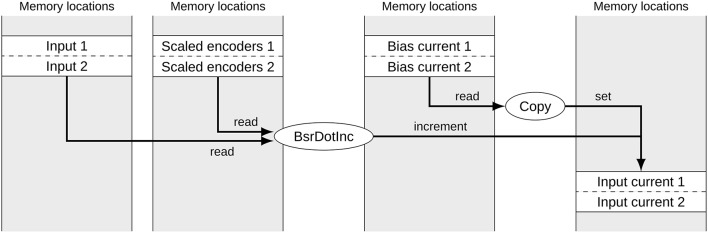
Signals and operators to calculate the input current to two neural groups after merging. The gray boxes represent memory locations with allocated signals. Ellipses represent operators accessing and modifying these signals. Due to the merging, the number of operators has been reduced to two and the memory access for corresponding signals is sequential.